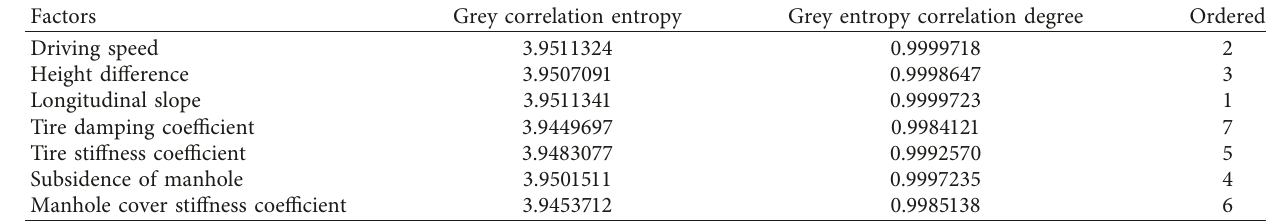
Table 4: Computed results and ordered correlation values of grey